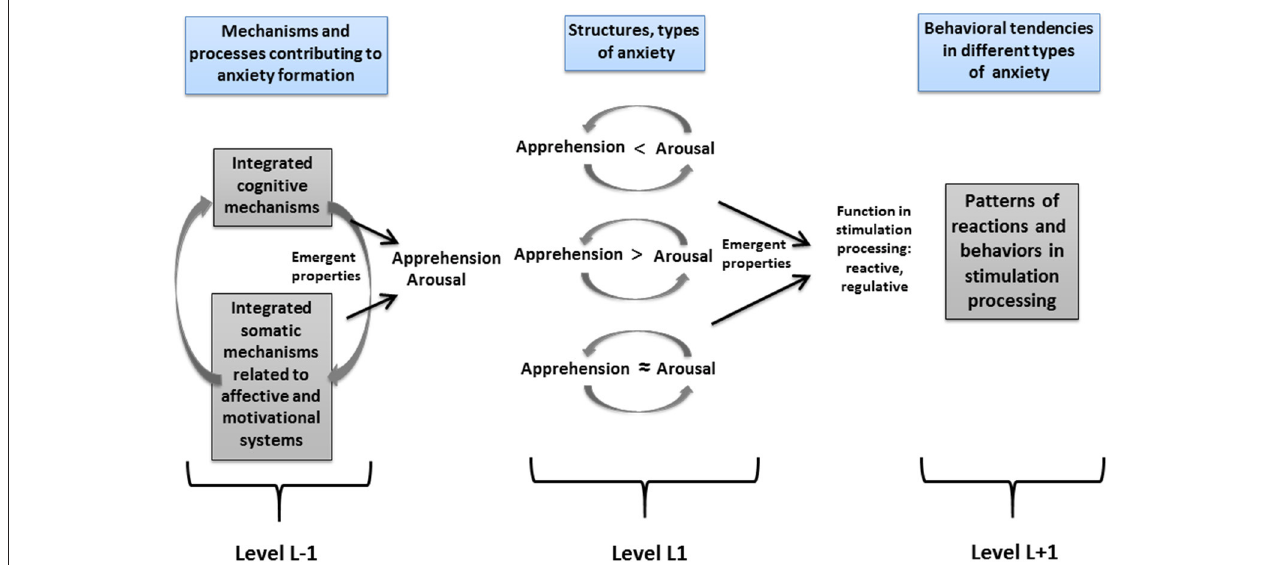
FIGURE 1 | The organization of anxiety types according to the three-level compositional hierarchy. Adapted from Fajkowska (2013), p. 107. Copyright by Eliot Werner, Clinton Corners, NY. Reprinted with